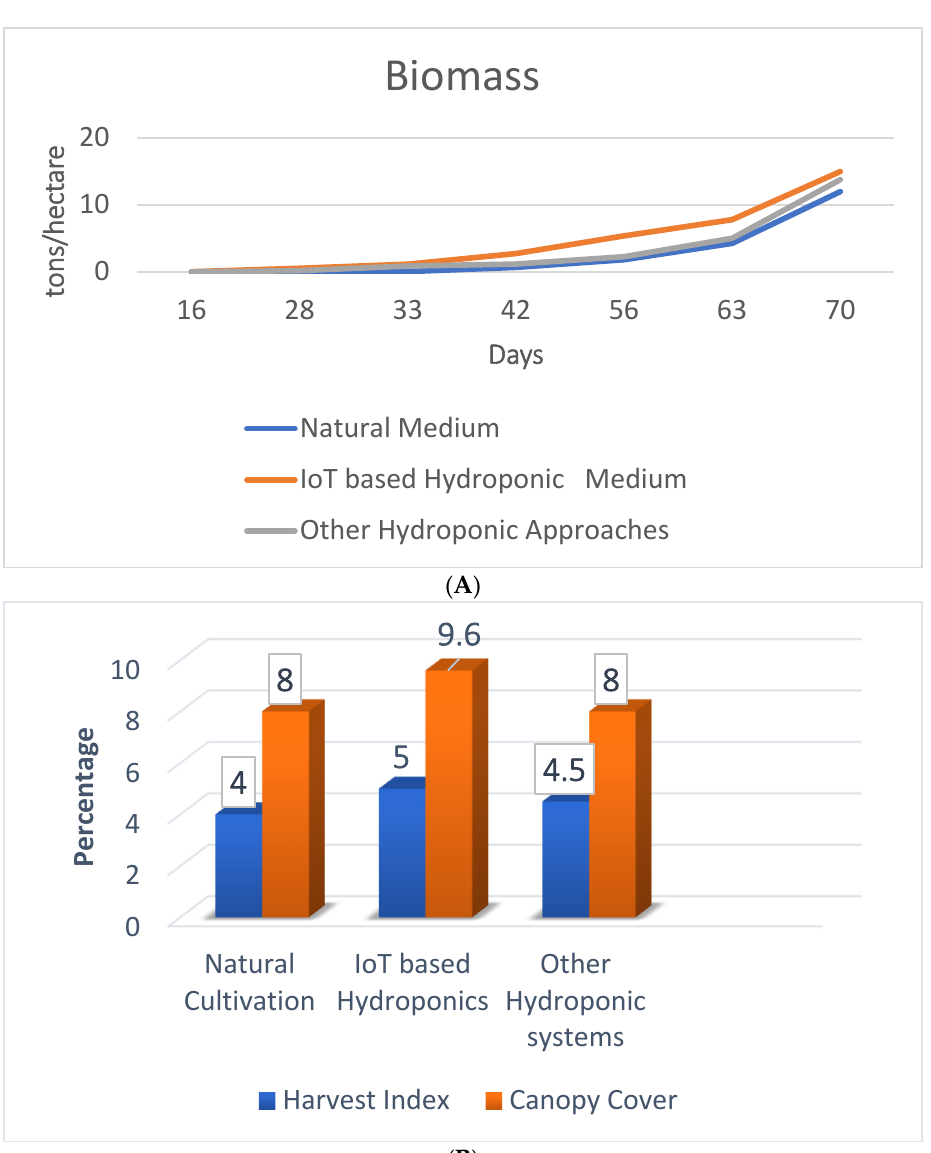
Figure 12. ( A ) Comparison of biomass in different saffron cultivation models. ( B ) Comparison of harvest index and canopy cover for different saffron cultivation models.